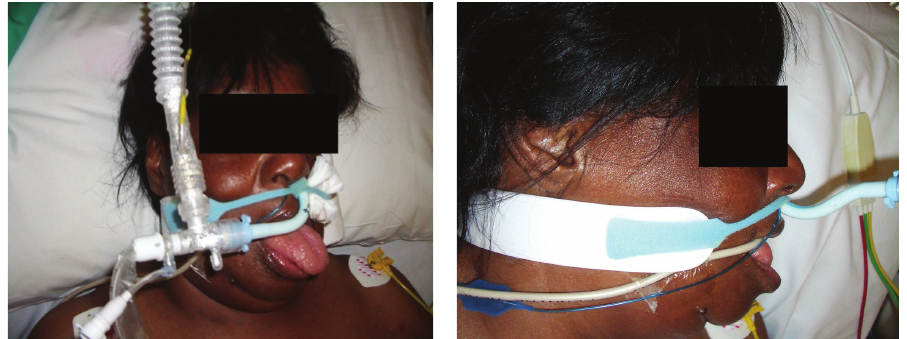
Figure 1: Before and after treatment with icatibant.